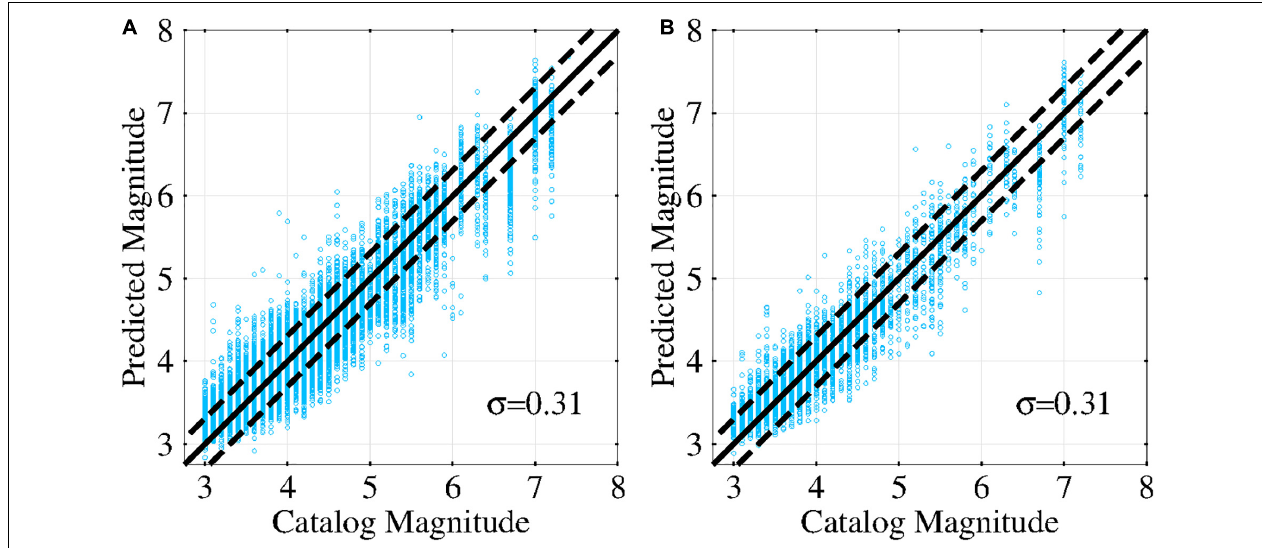
FIGURE 4 | Correlations between the predicted and catalog magnitudes. (A) Magnitude estimation for the training dataset used to train the DCNN-M model. (B) The magnitude estimation of the test dataset used to test the DCNN-M model performance. When a data point is on the solid black 45 ◦ line, the predicted magnitude is equal to the catalog magnitude. The two black dashed lines indicate the range of one standard deviation of error.